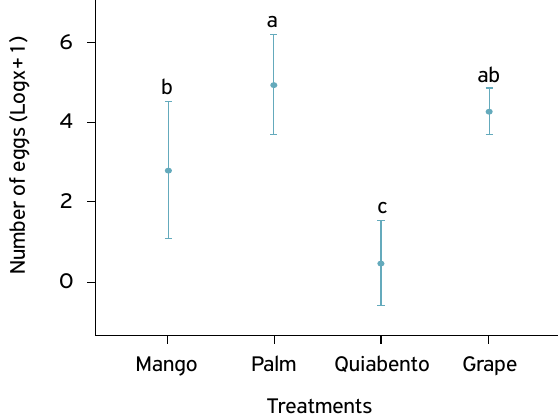
Figure 1. Mean number of eggs C. capitata in fruit of mango, palm, quiabento and grape. Means followed by equal letters do not differ by Tukey test (p<0.05). Vitória da Conquista, BA,